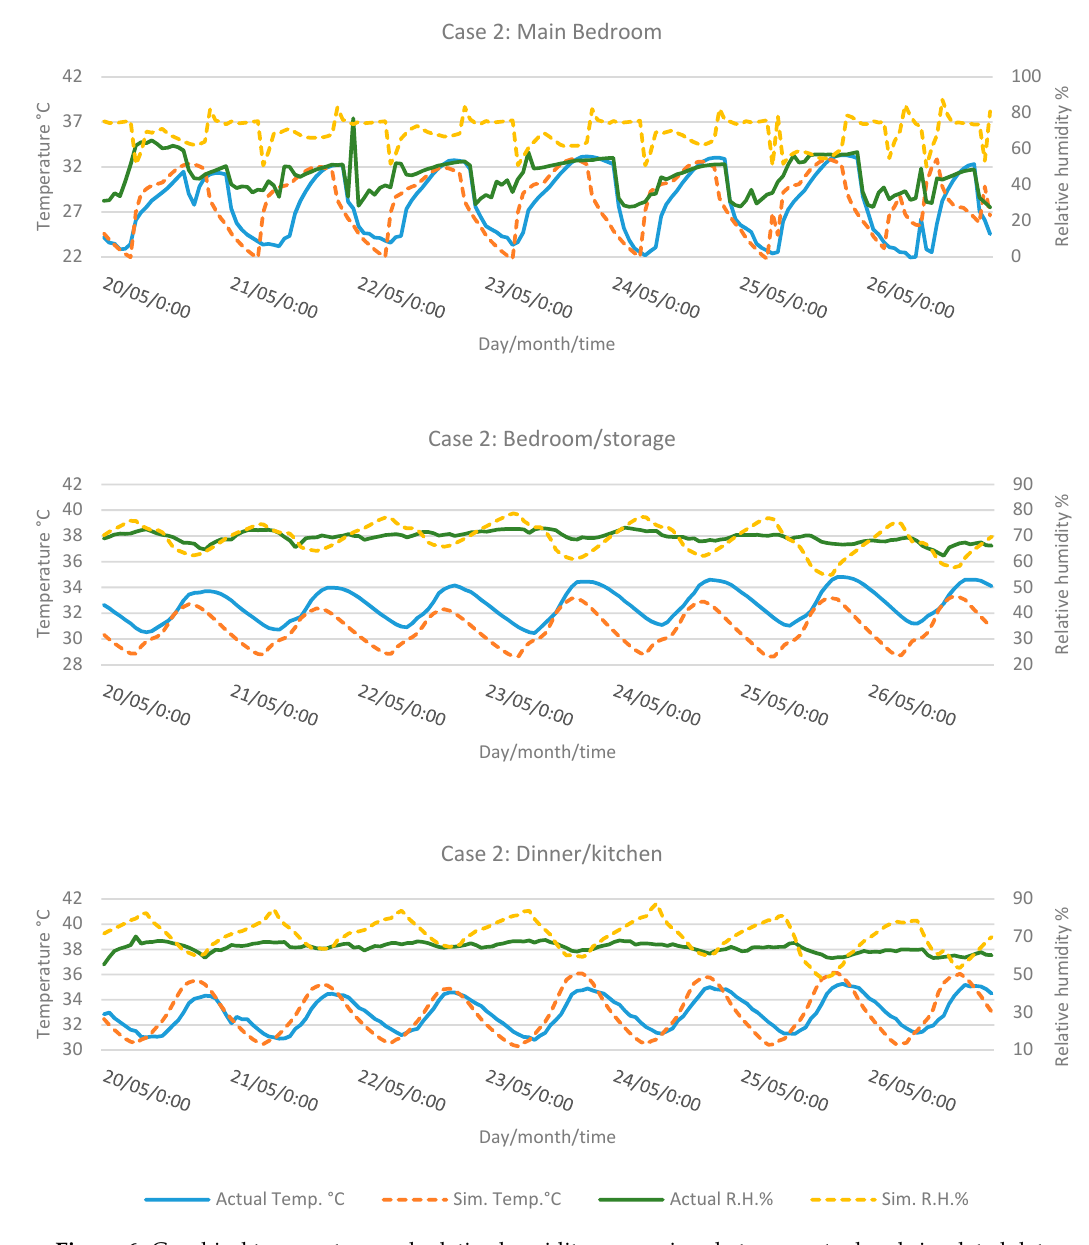
Figure 6. Graphical temperature and relative humidity comparison between actual and simulated data in each zone for Case 2